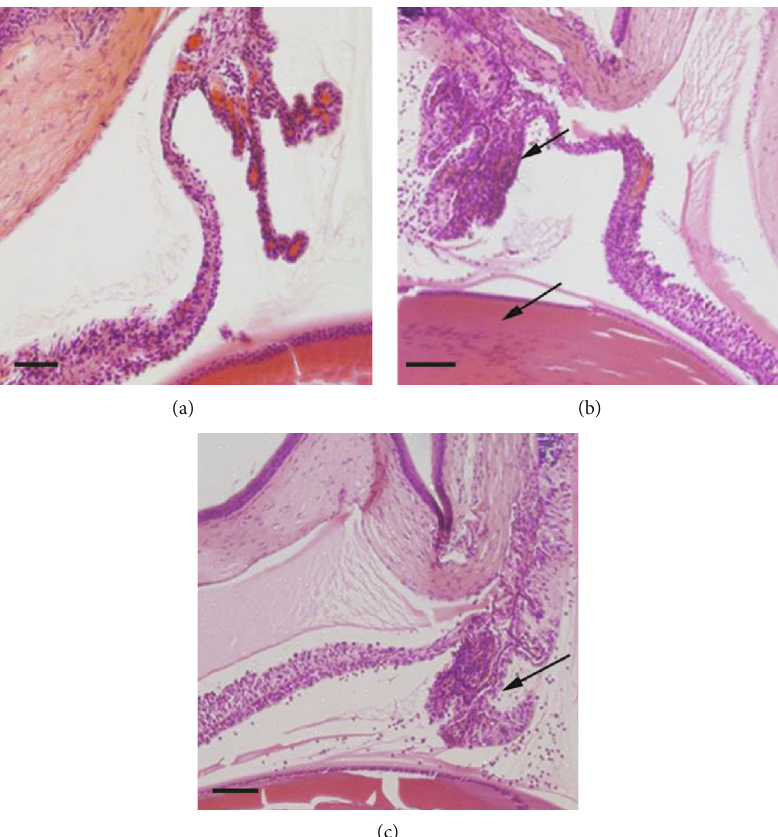
Figure 3: Histopathological fi ndings. (a) No in fl ammatory cell in fi ltration was observed in the NC group. (b) In the EIU group, there was a large in fi ltration of in fl ammatory cells (the top arrow) in the iris stroma and corneal endothelium (the bottom arrow pointed to the lens). (c) Only a small amount of scattered in fl ammatory cells were observed in the ET group (the arrow pointed to the iris ciliary body). Scale bars: 100 μ m.